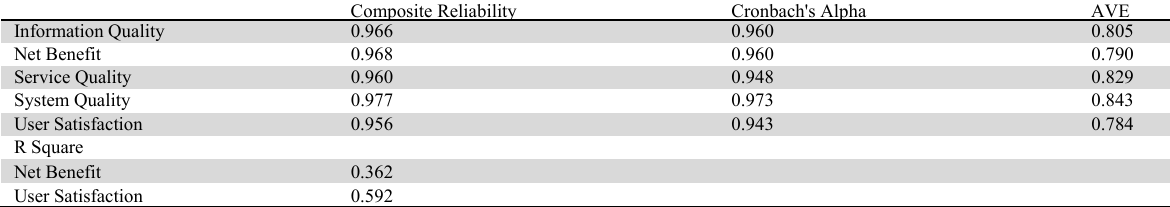
Composite Reliability and Cronbach's Alpha